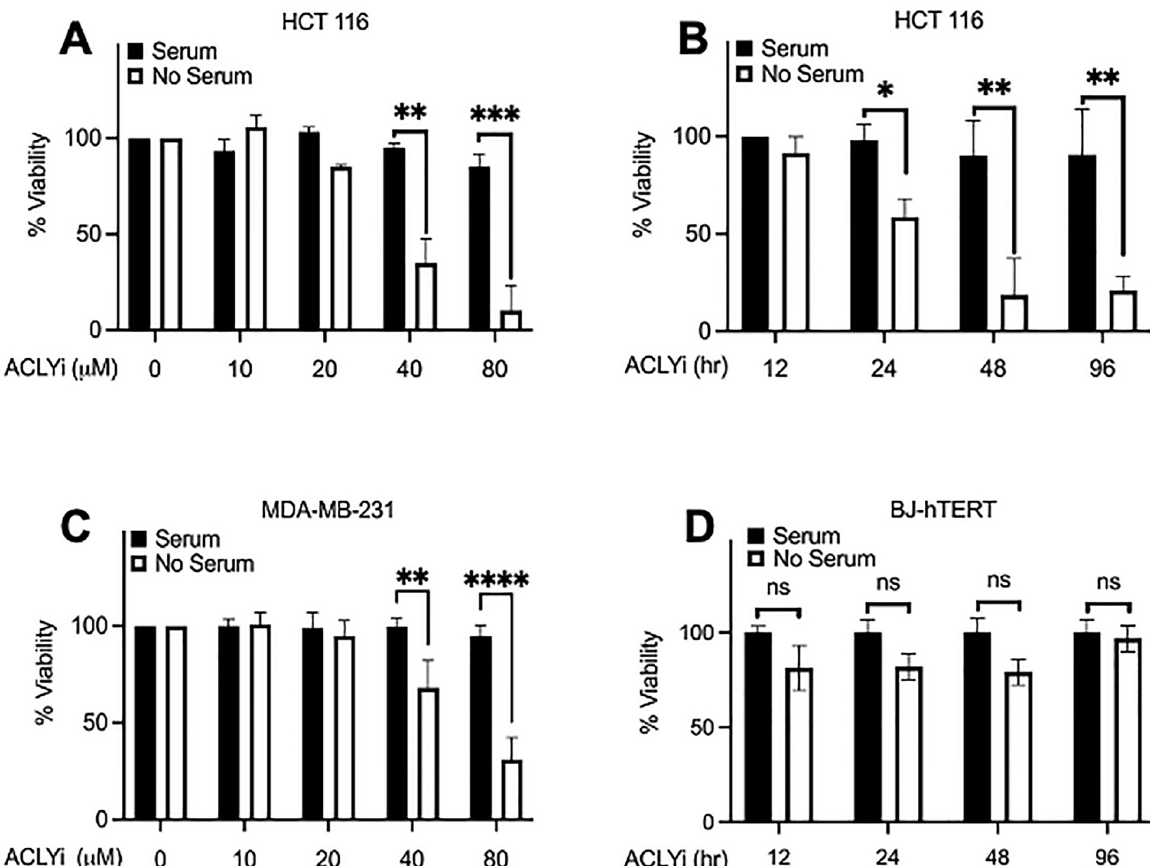
Fig 3. Cytotoxic effect of ACLY inhibition in the absence of serum in KRas-driven cancer cells. ( A ) HCT116 cells were plated at 60% confluence in 96-well plate in complete medium (CM) containing 10% FBS. After 24 hr, cells were shifted to medium with or without serum. Next, cells were transferred into media containing concentrations of 10 μ M, 20 μ M, 40 μ M, and 80 μ M ACLYi (SB-204990) for 24 hr. XTT assay was performed for cell viability. ( B ) HCT116 cells were plated as in A . After 24 hr, cells were shifted to medium with or without serum. Next, cells were transferred into media containing SB-204990 (40 μ M) for 12 hr, 24 hr, 48 hr, and 96 hr time points. XTT assay was performed for cell viability. ( C ) MDA-MB-231 cells were plated and treated as in A . XTT assay was performed for cell viability. ( D ) BJ-hTERT cells were plated and treated as in B . XTT assay was performed for cell viability. All experiments were repeated two or more times. Error bars represent ± SEM. Unpaired Student’s t- test was performed for statistical analysis.